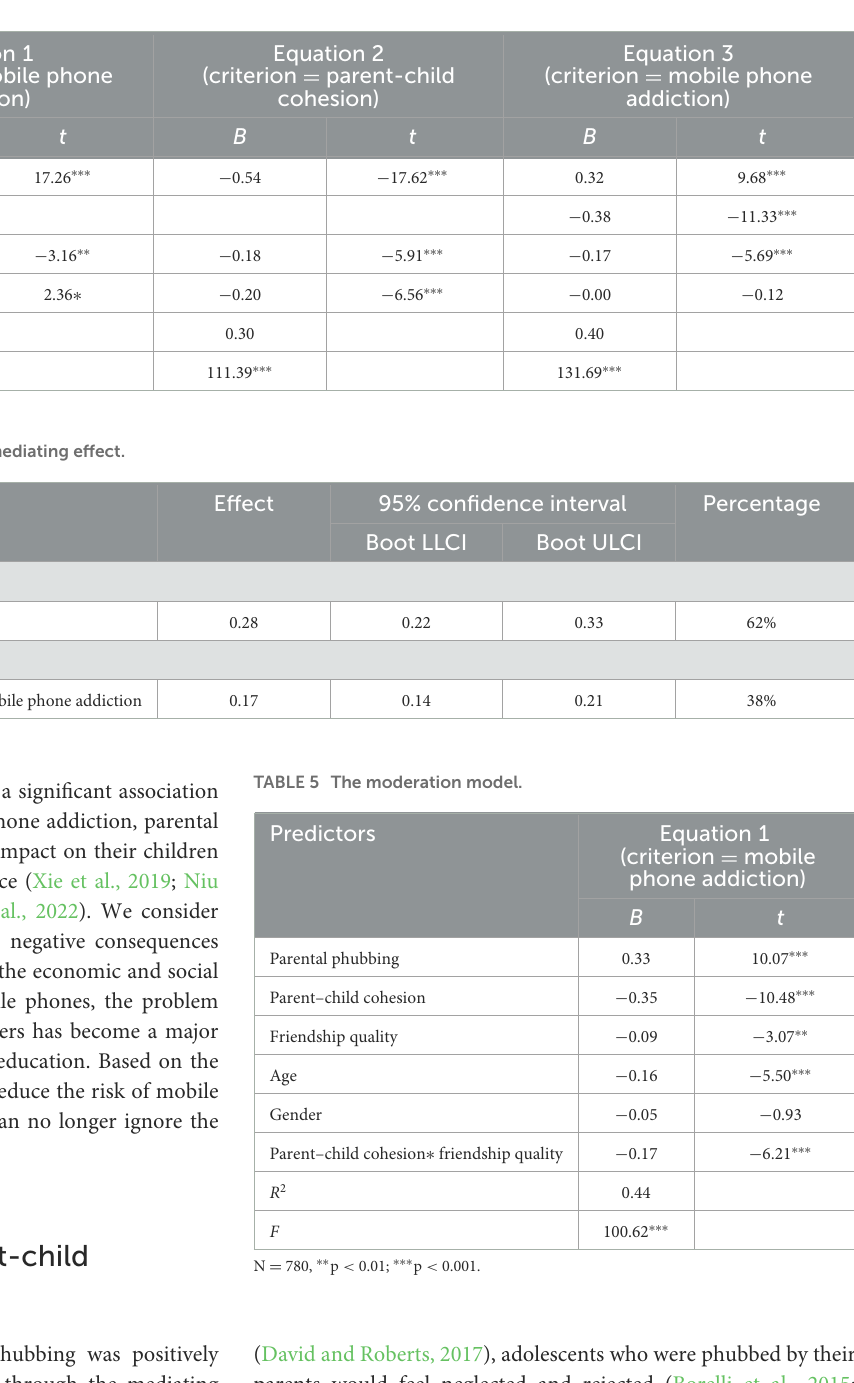
TABLE 3 The mediation model.